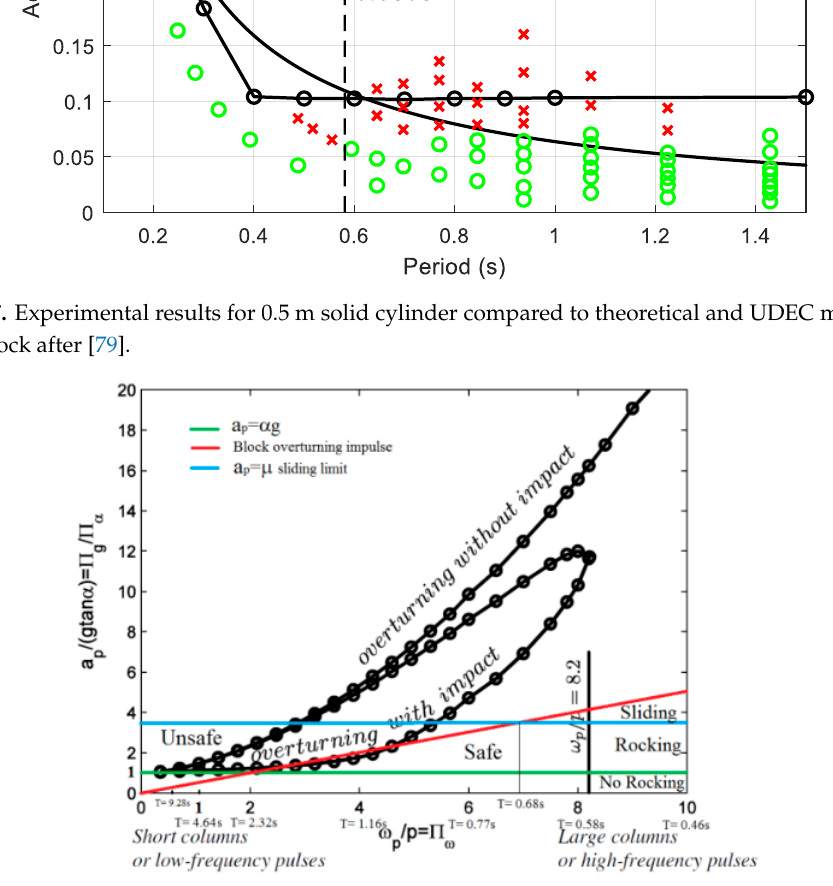
Figure 8. Safe–unsafe boundary for half sine impulse drawn on top of the overturning acceleration spectrum of the freestanding rocking column with tan α = 0.25 when it is subjected to a one-sine acceleration pulse after Makris and Kampas